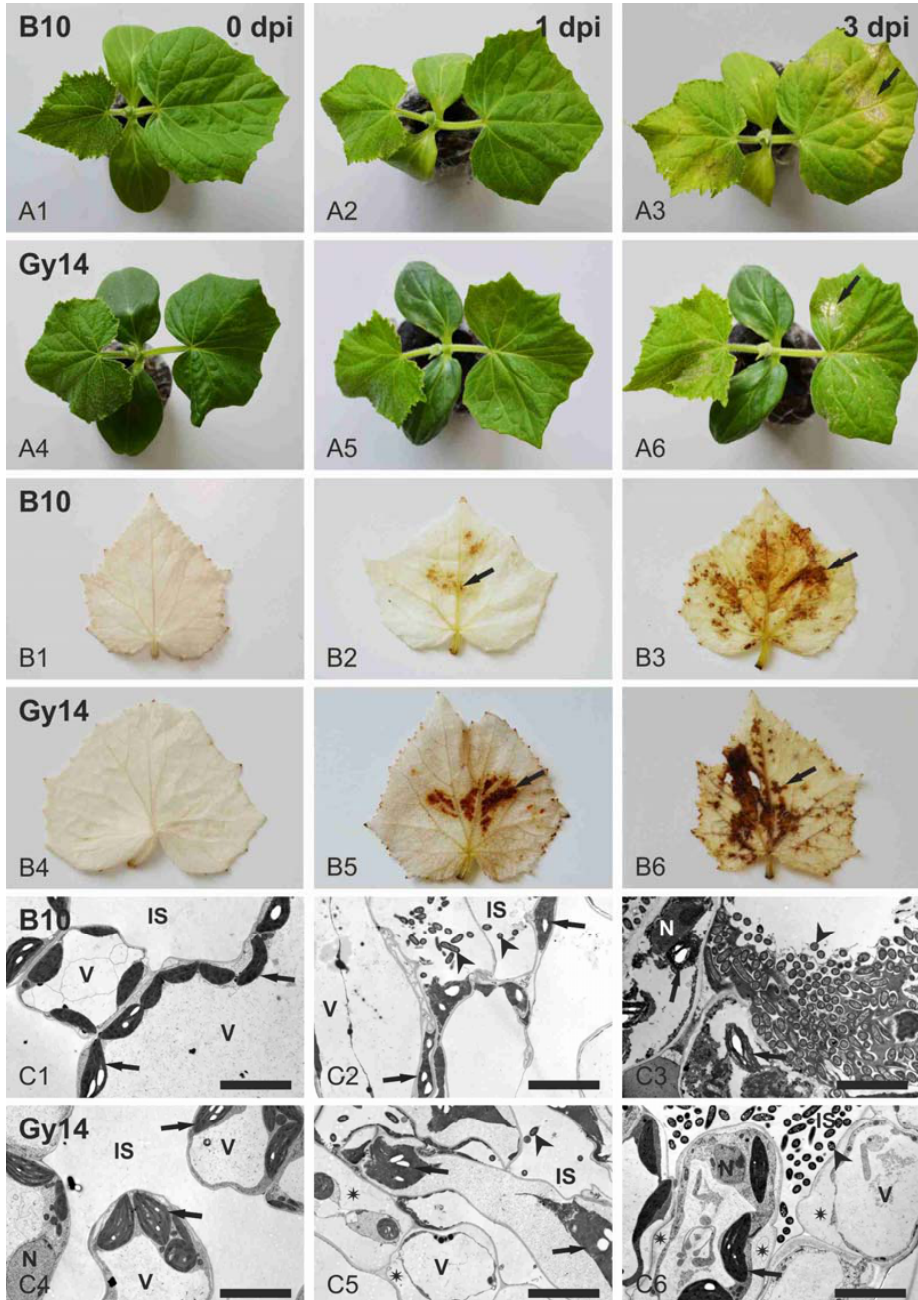
Figure 1. Morphology and ultrastructure of leaves of susceptible B10 and resistant Gy14 cucumber lines upon infection with the Psl 814/98 strain (inoculum concentration of 1 × 10 7 CFU mL − 1 ). ( A ) Morphology of inoculated cucumber leaves (arrows indicate selected lesions); ( A1 – A3 ), B10 plants at 0, 1 and 3 dpi, respectively; ( A4 – A6 ), Gy14 plants at 0, 1 and 3 dpi, respectively. ( B ) H 2 O 2 accumulation in leaves as indicated by staining with DAB (arrows point to selected DAB precipitates); ( B1 – B3 ), B10 plants at 0, 1 and 3 dpi, respectively; ( B4 – B6 ), Gy14 plants at 0, 1 and 3 dpi, respectively. ( C ) Transmission electron microscopy micrographs of leaf mesophyll cells (arrowheads indicate selected bacteria; arrows indicate selected chloroplasts; asterisks indicate regions between plasma membrane and cell wall in plasmolyzed cells); ( C1 – C3 ), B10 plants at 0, 1 and 3 dpi, respectively; ( C4 – C6 ), Gy14 plants at 0, 1 and 3 dpi, respectively. Abbreviations: IS—intercellular space, N— nucleus, V—vacuole. Scale bars, 5 µ m ( C